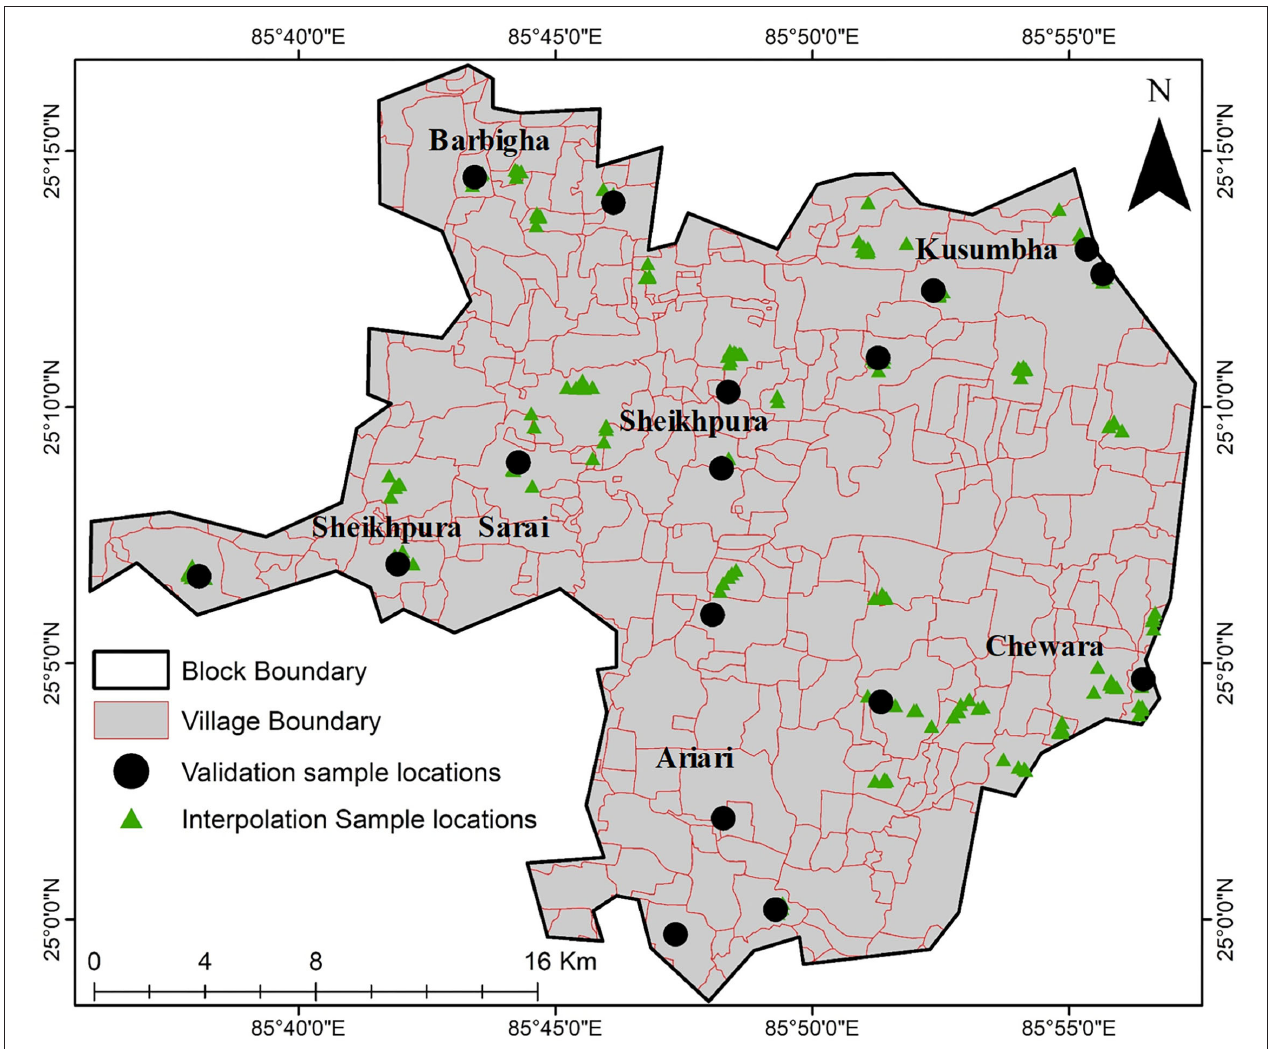
FIGURE 1 | Village map of Sheikhpura district indicates groundwater sample locations ( N = 206) (source: